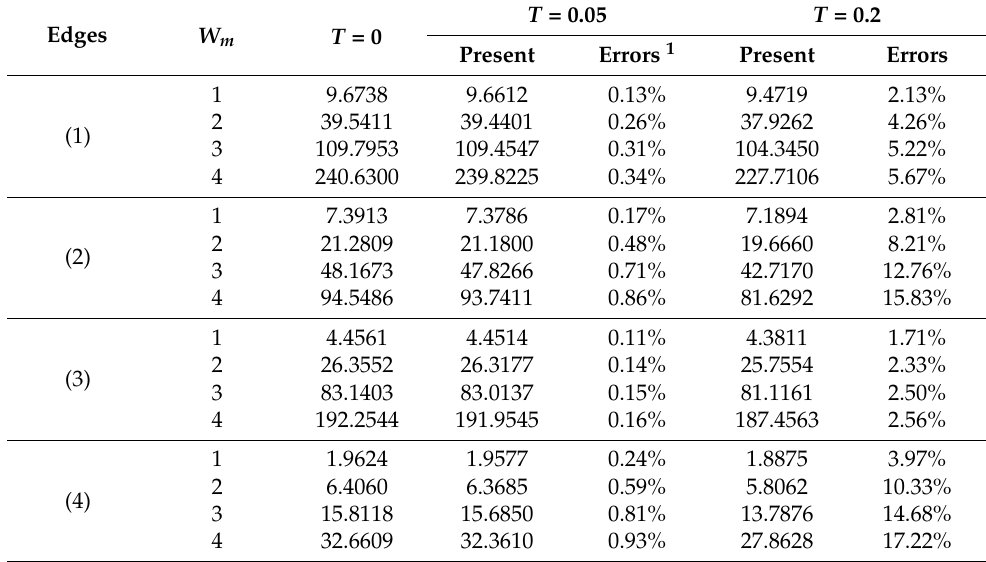
Table 3. Computational values of P and errors for T (cid:54) = 0 and T = 0.